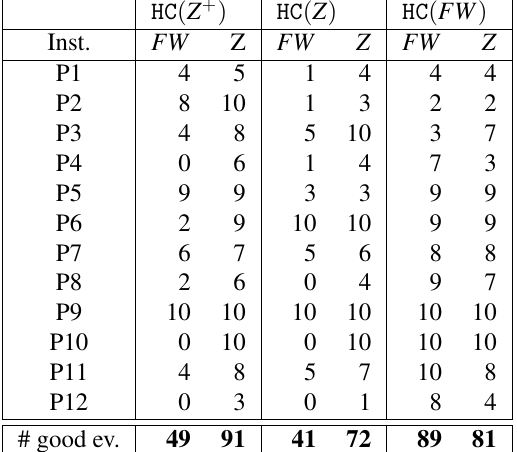
Table 7. Comparison among different cost functions to guide the